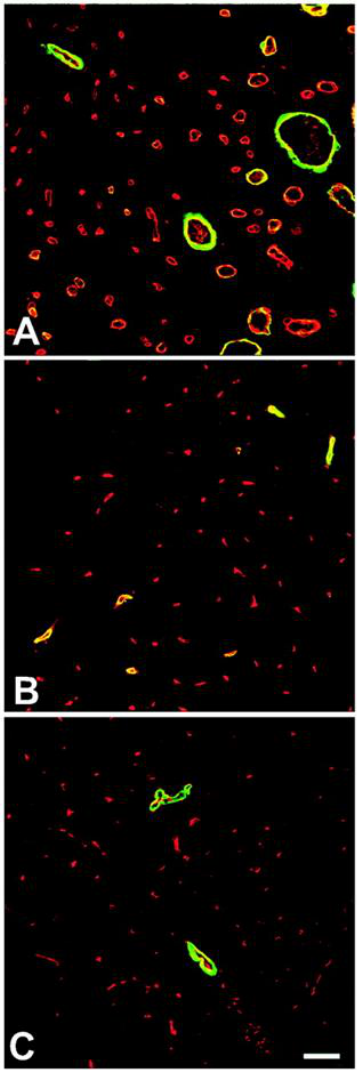
Figure 1. Activation of microbubbles with ultrasound can elicit arteriogenesis. Confocal micrographs illustrating the expression of SM α -actin (green fluorescence) in relation to microvessels, as labeled with BS-I lectin (red fluorescence). Images were taken 14 days after muscles were exposed to US-MB treatment ( A ) or sham treatment ( B ). Panel ( C ) represents the untreated muscle. Note the increased number and caliber of SM α -actin + vessels with US + MB treatment ( A ). Bar = 30 µ m. Adapted from Song et al. [32].